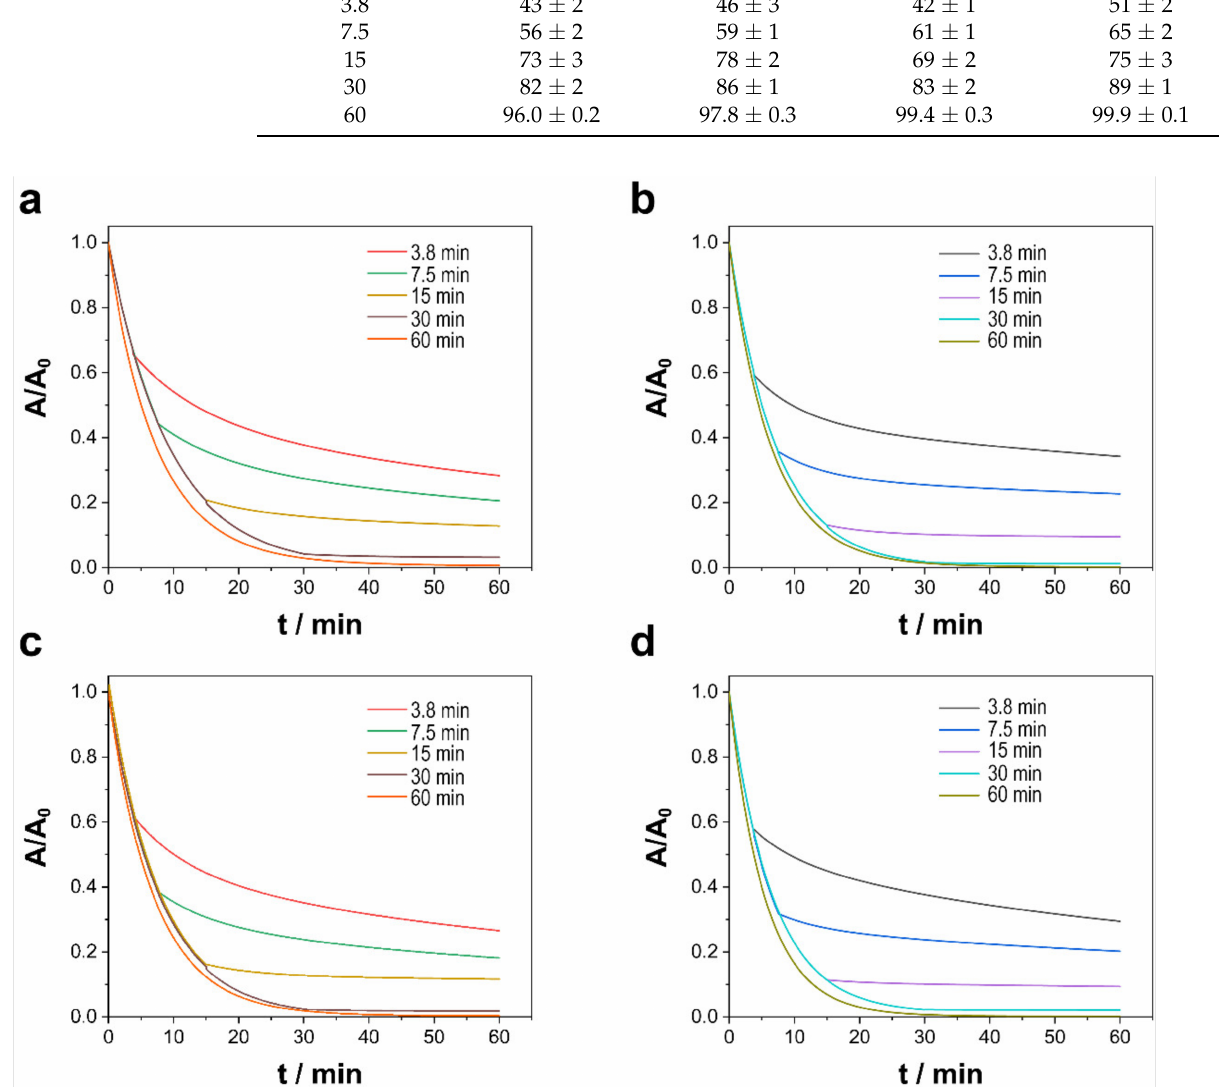
Figure 7. Catalytic degradation of TCs as a function of the catalyst contact duration of ( a , c ) Ni–CoNi and ( b , d ) Co–CoNi deposits at ( a , b ) pH 6.0 and ( c , d ) pH 8.0. Experimental conditions: 20 ppm of